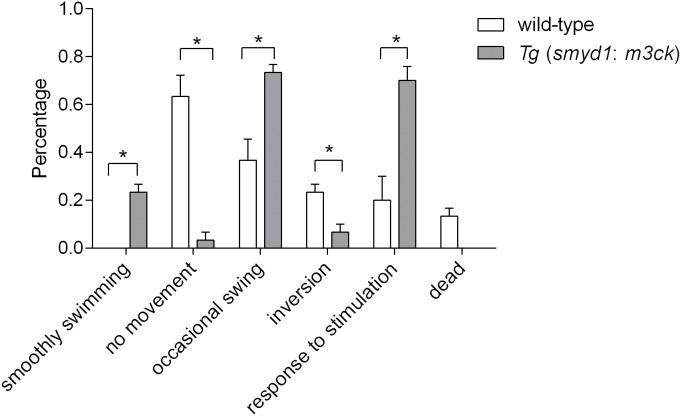
Status of transgenic and non-transgenic fish at 13°C.The percentages smooth swimming, occasional swing, response to external stimulation, no movement, inversion, and dead fish were recorded. Data were analyzed by one-way ANOVA and t-test to compare data between fish lines. Data represent mean ± S.E.M. (n = 30). “*”indicates P<0.05.